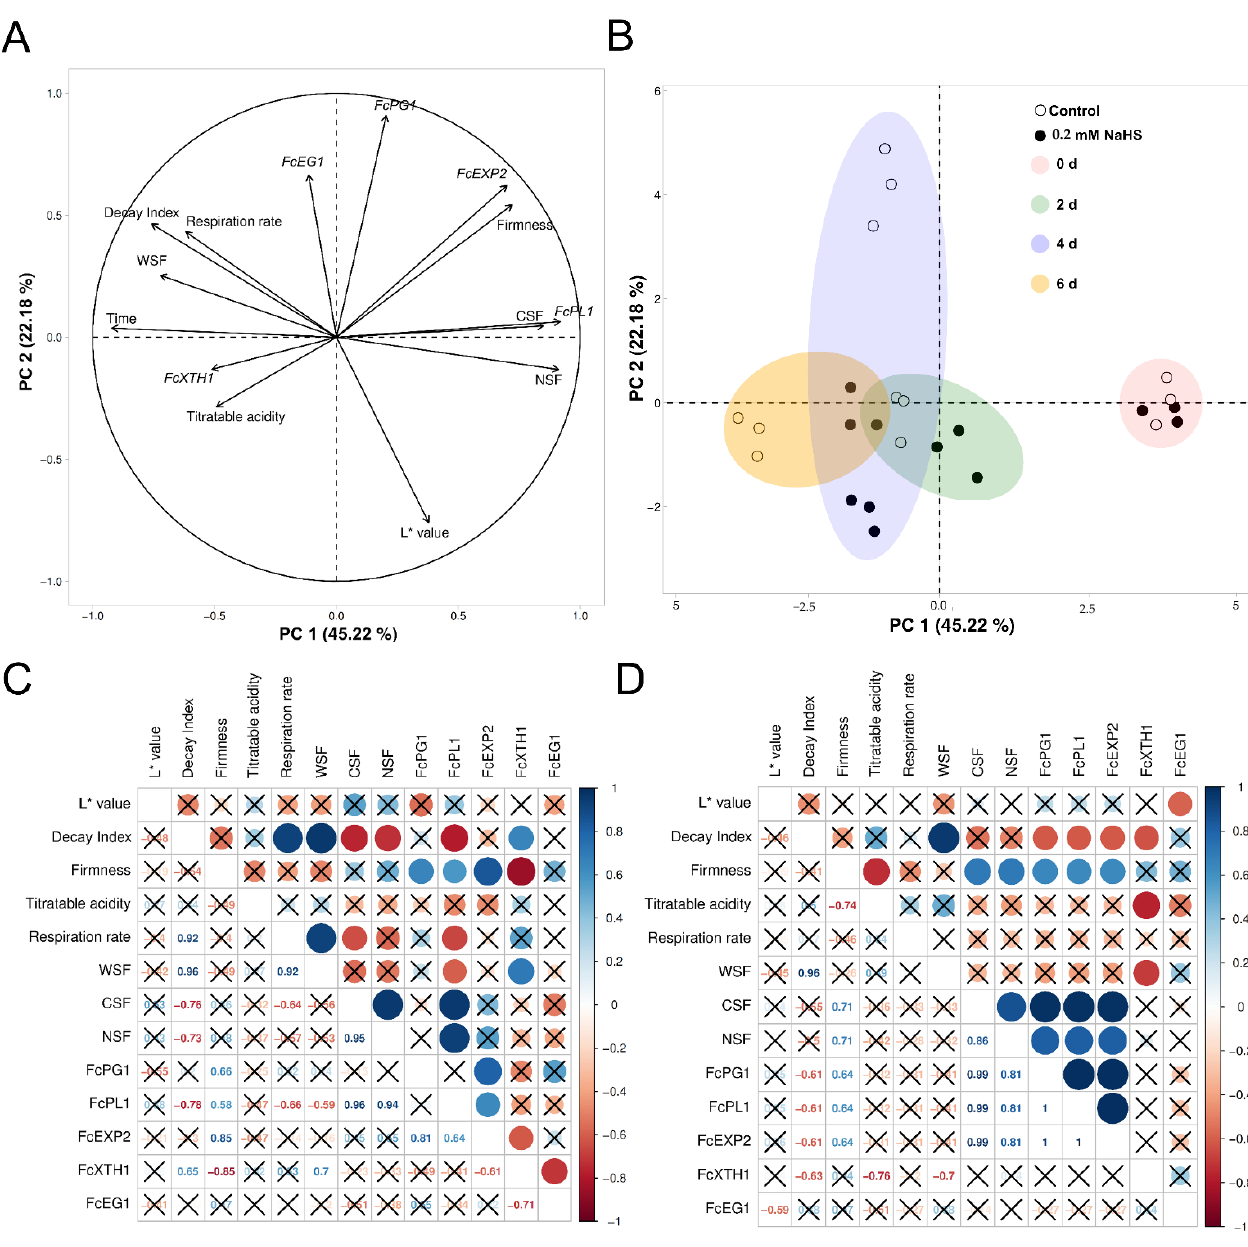
Figure 6. Principal component (PCA) and correlation analyses of Chilean strawberry ( Fragaria chiloensis ) fruit in response to H 2 S treatment during postharvest shelf-life: ( A ) Graph of variables; ( B ) Graph showing the response of F. chiloensis fruit to 0.2 mM NaHS treatment along storage time. Correlation graph of ( C ) control and ( D ) H 2 S-treated fruit. For details, see Section 4.